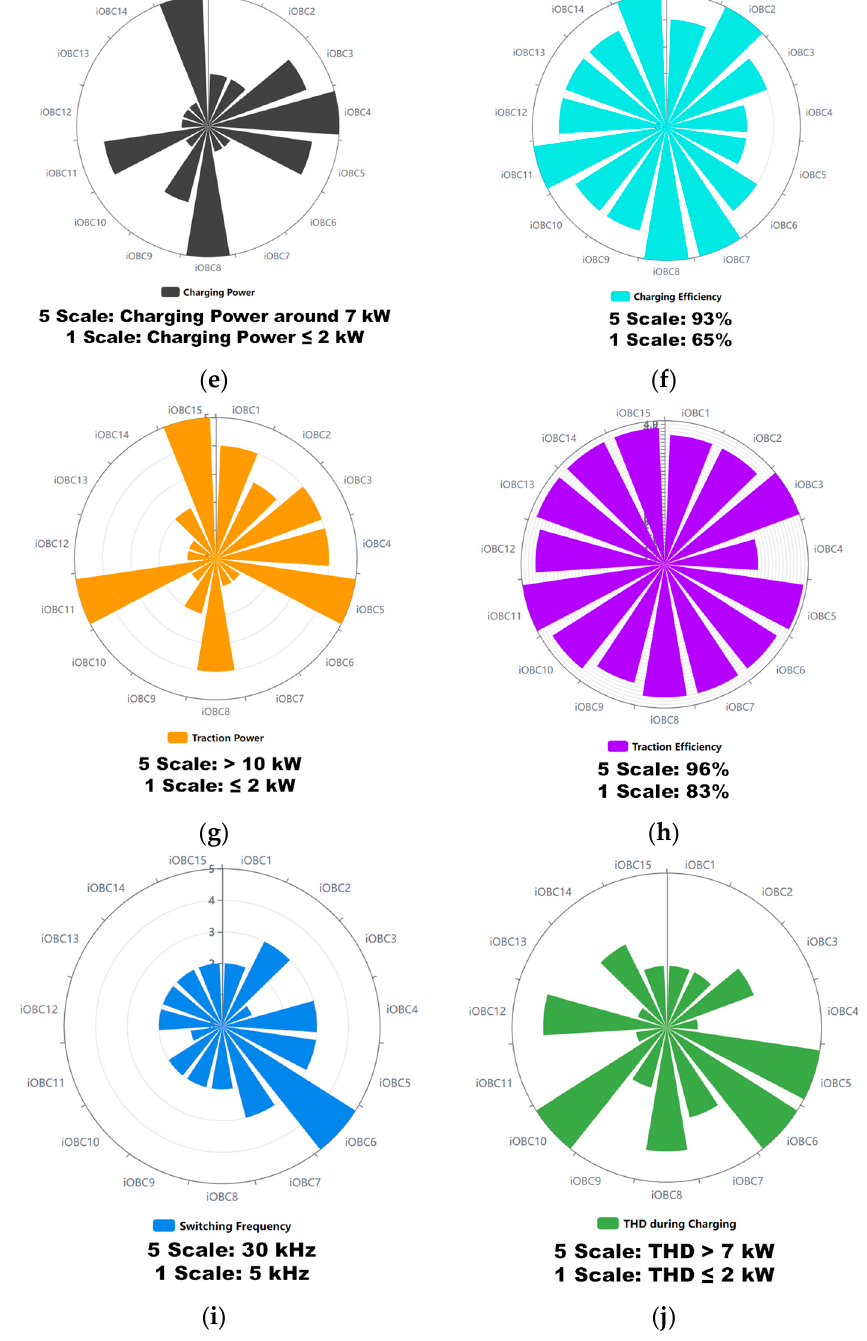
Figure 31. Qualitative analysis of iOBC topologies, ( a ) Total number of components used, ( b ) V2G Capability( c ) Controllability, ( d ) Reliability/Redundancy, ( e ) Charging power, ( f ) Charging efficiency, ( g ) Traction power, ( h ) Traction efficiency, ( i ) Switching frequency, ( j ) THD during charging.